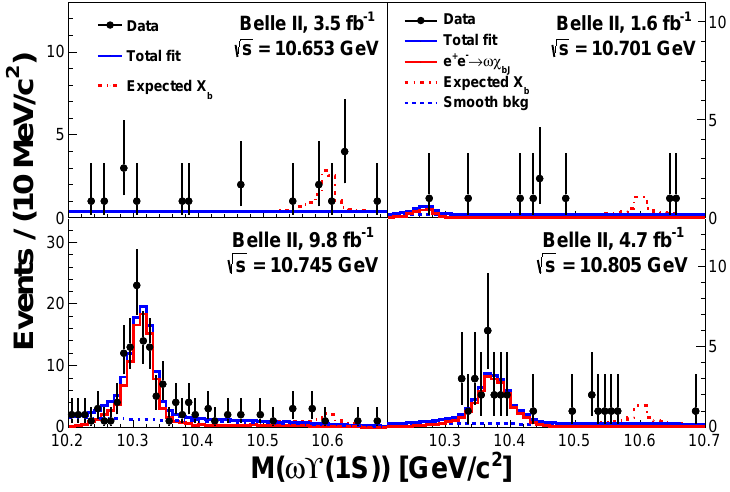
√ s = 10.653, 10.701,